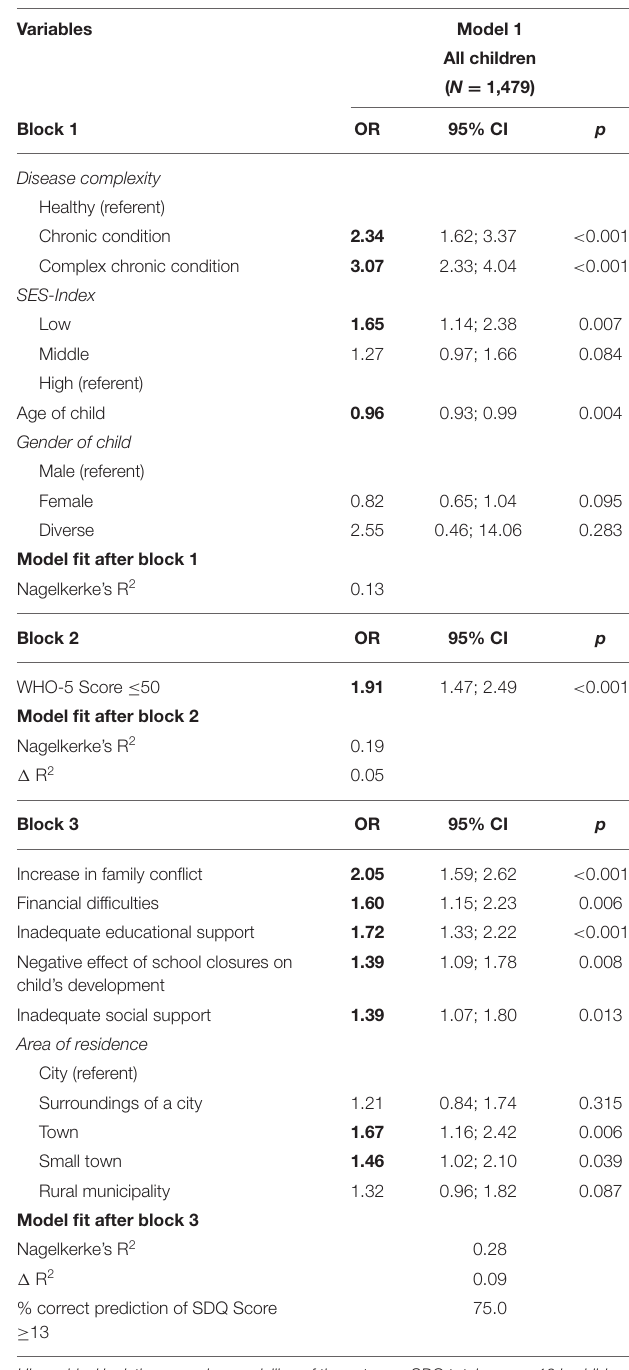
TABLE 4 | Impact of socioeconomic status and psychosocial burden on parent-reported child mental health